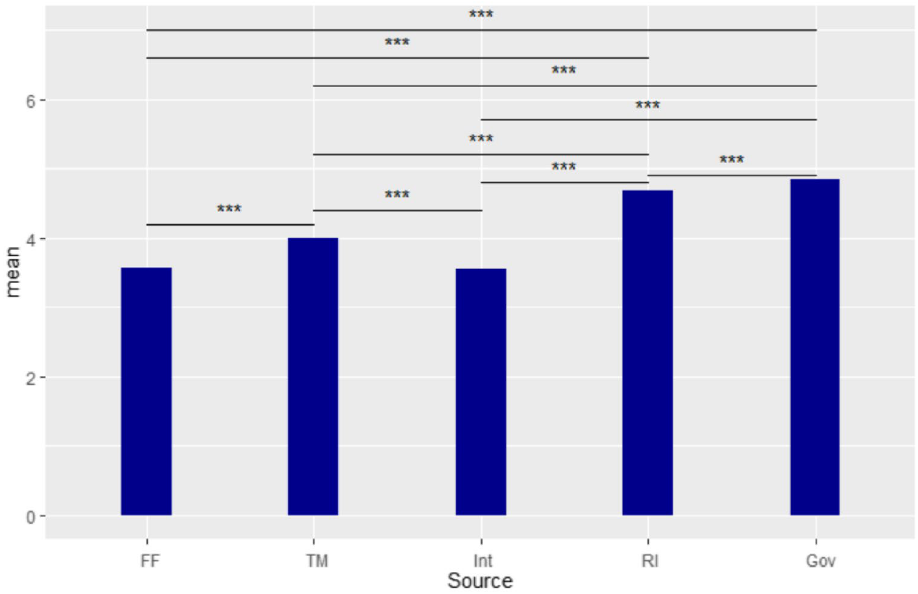
Figure 3. Information Credibility Comparisons. Note: *** p < .001. FF = family members and friends; TM = traditional media; Int = the Internet and social media; RI = research institutes; Gov = government.